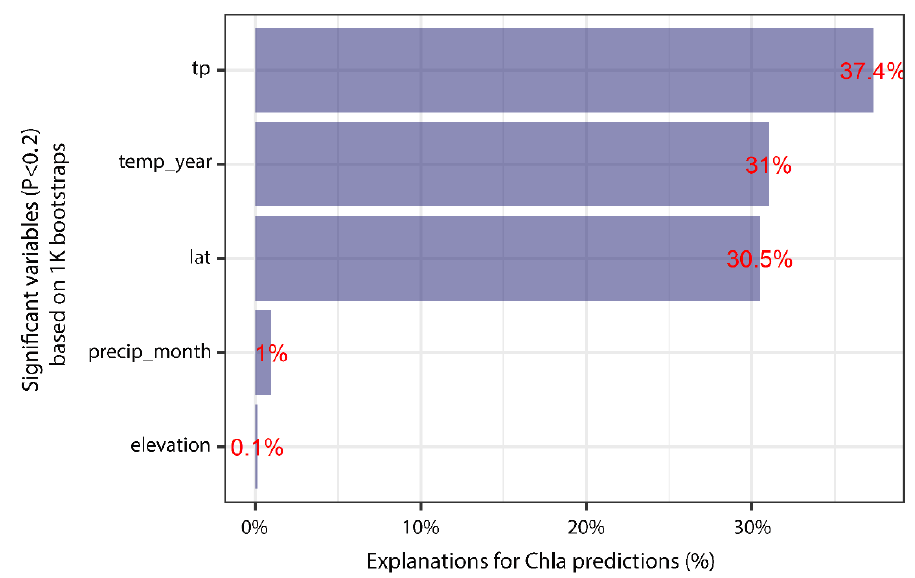
Figure 7. Variable interpretation rate based on ecological effects ( p < 0.2).